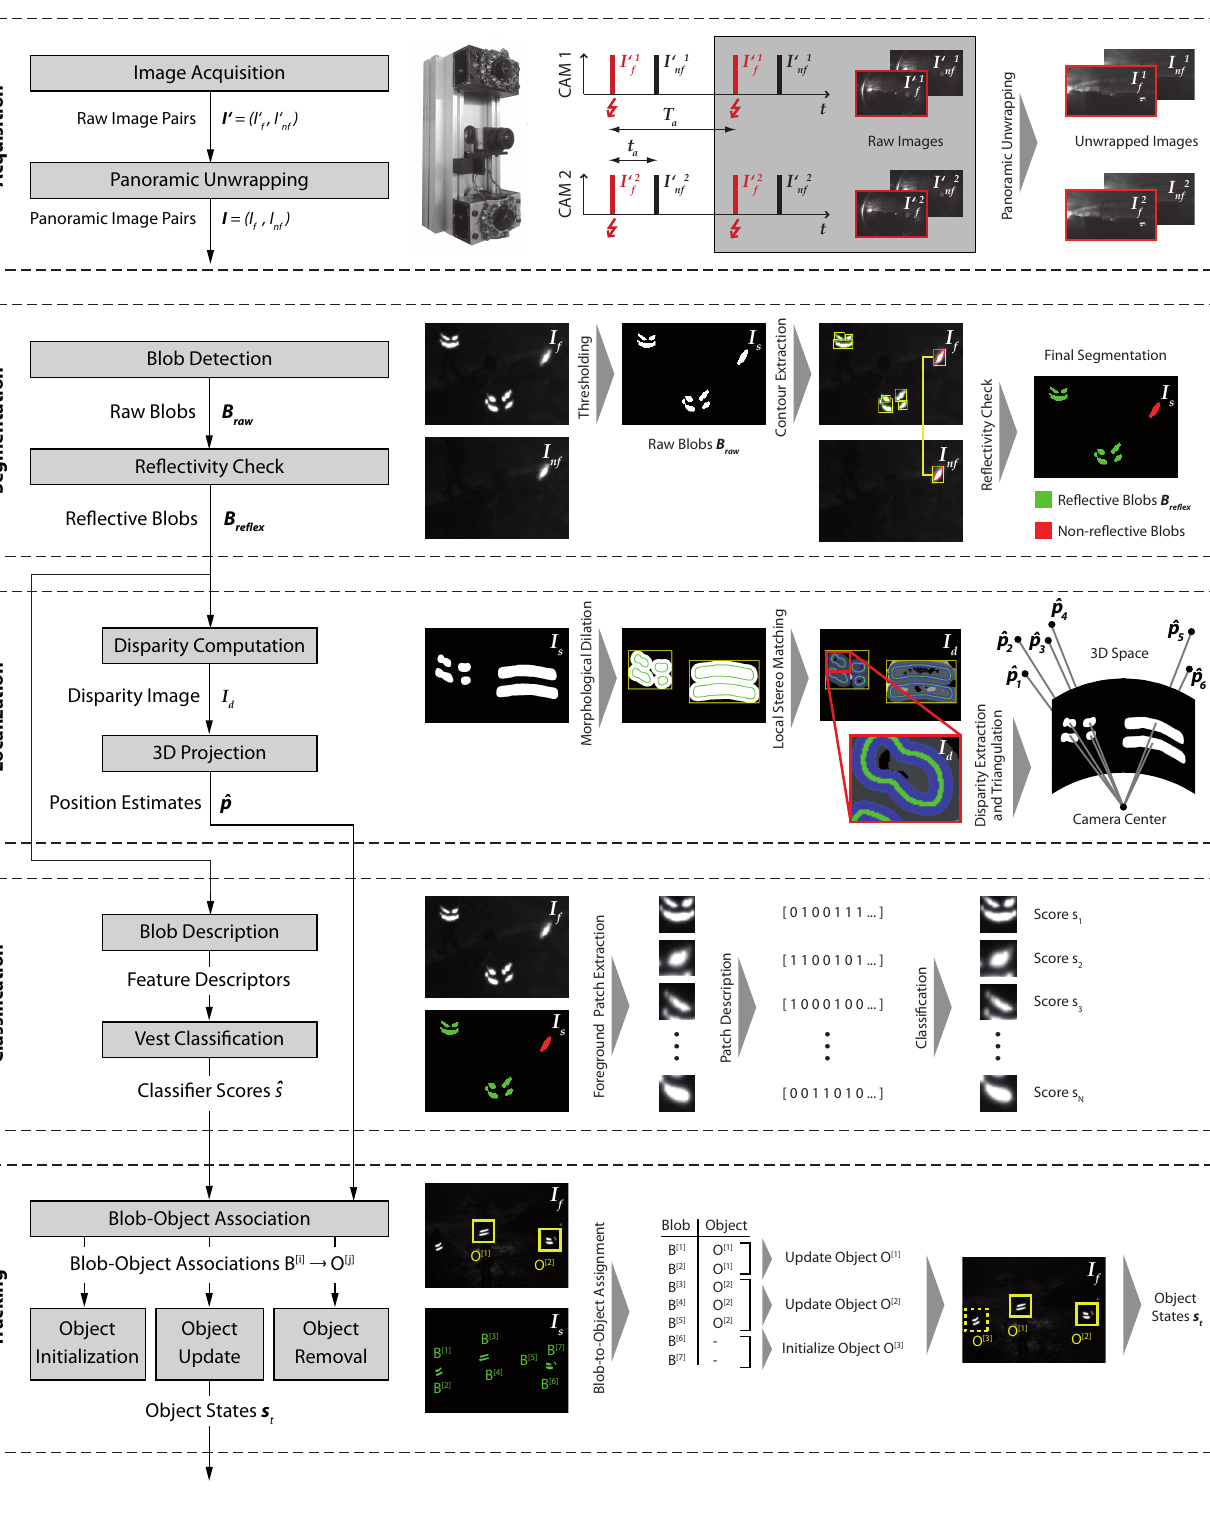
Figure 2. Schematic overview of the different stages of our human tracking